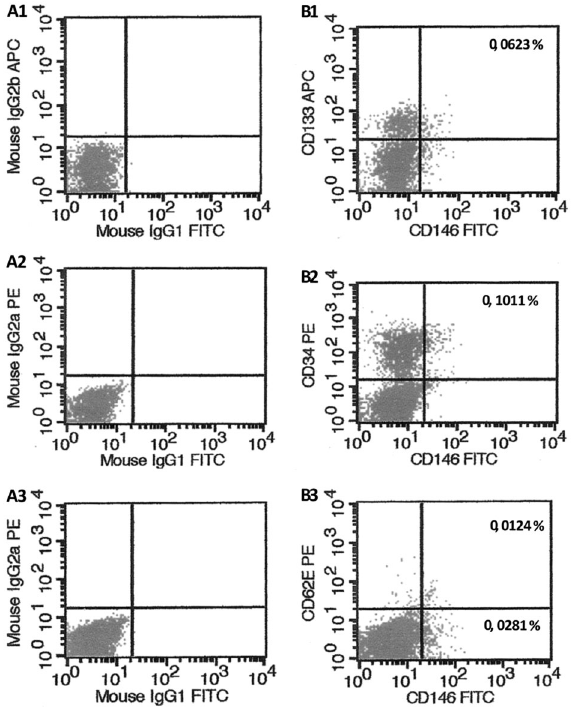
Figure 2. Flow cytometry analyses of endothelial cells in venous blood samples from chronic myeloid leukemia (CML) patients in blast crisis. A1 , A2 and A3 , corresponding isotypic control. B1 , endothelial precursor cells (EPCs) expressing CD45 –/dim / CD146 + /CD133 + ; and B2 , CD45 -/dim /CD146 + /CD34 + . B3 , Characterization of activated mature circulating endothelial cells expressing CD45 -/dim /CD146 + /CD62e + and mCEC (CD45 -/dim / CD146 + /CD62e - ).